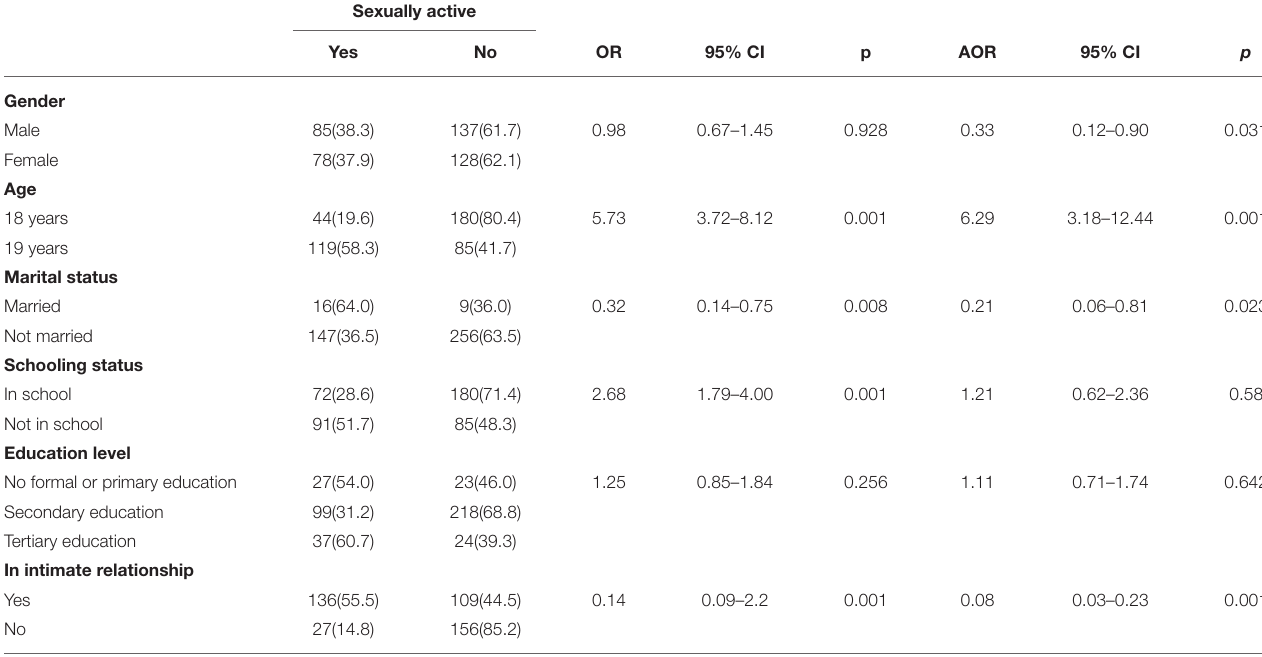
TABLE 3 | Covariates of being sexually active among adolescents in Plateau State, Nigeria ( N =